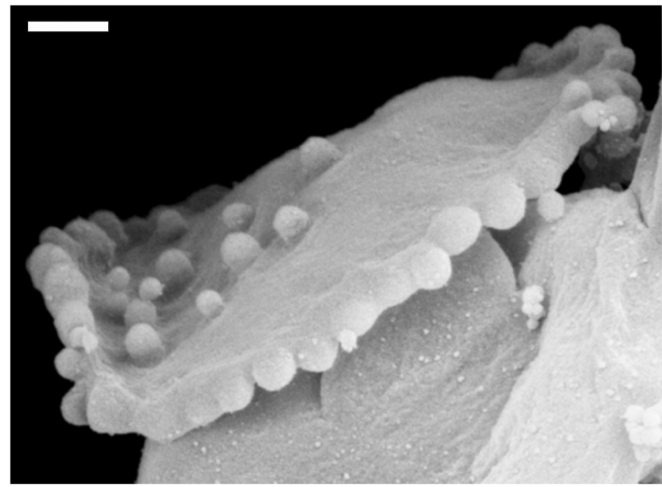
Figure 27. Scanning electron microscope image of a vesicular structure found in the isolate from peripheral blood of a healthy human donor. Fresh blood taken into a vacutube with anticoagulant trisodium citrate was centrifuged at 1500 × g to sediment erythrocytes. The upper plasma, poor with platelets was then repeatedly centrifuged at high speed (17,570 × g ) and washed with phosphate and citrate buffered saline to isolate fragments of blood cells. Some residual cells, mostly platelets are usually also present in the isolate. The size and the shape of the structure indicates that it derives from a residual platelet. It is however likely that the assembly would integrate parts of membranes of other cells, e.g., erythrocytes and leukocytes during the processing of blood. Similar structures (with budding edge) of different sizes are often found in microvesicle isolates from blood. (Top bar equals 500